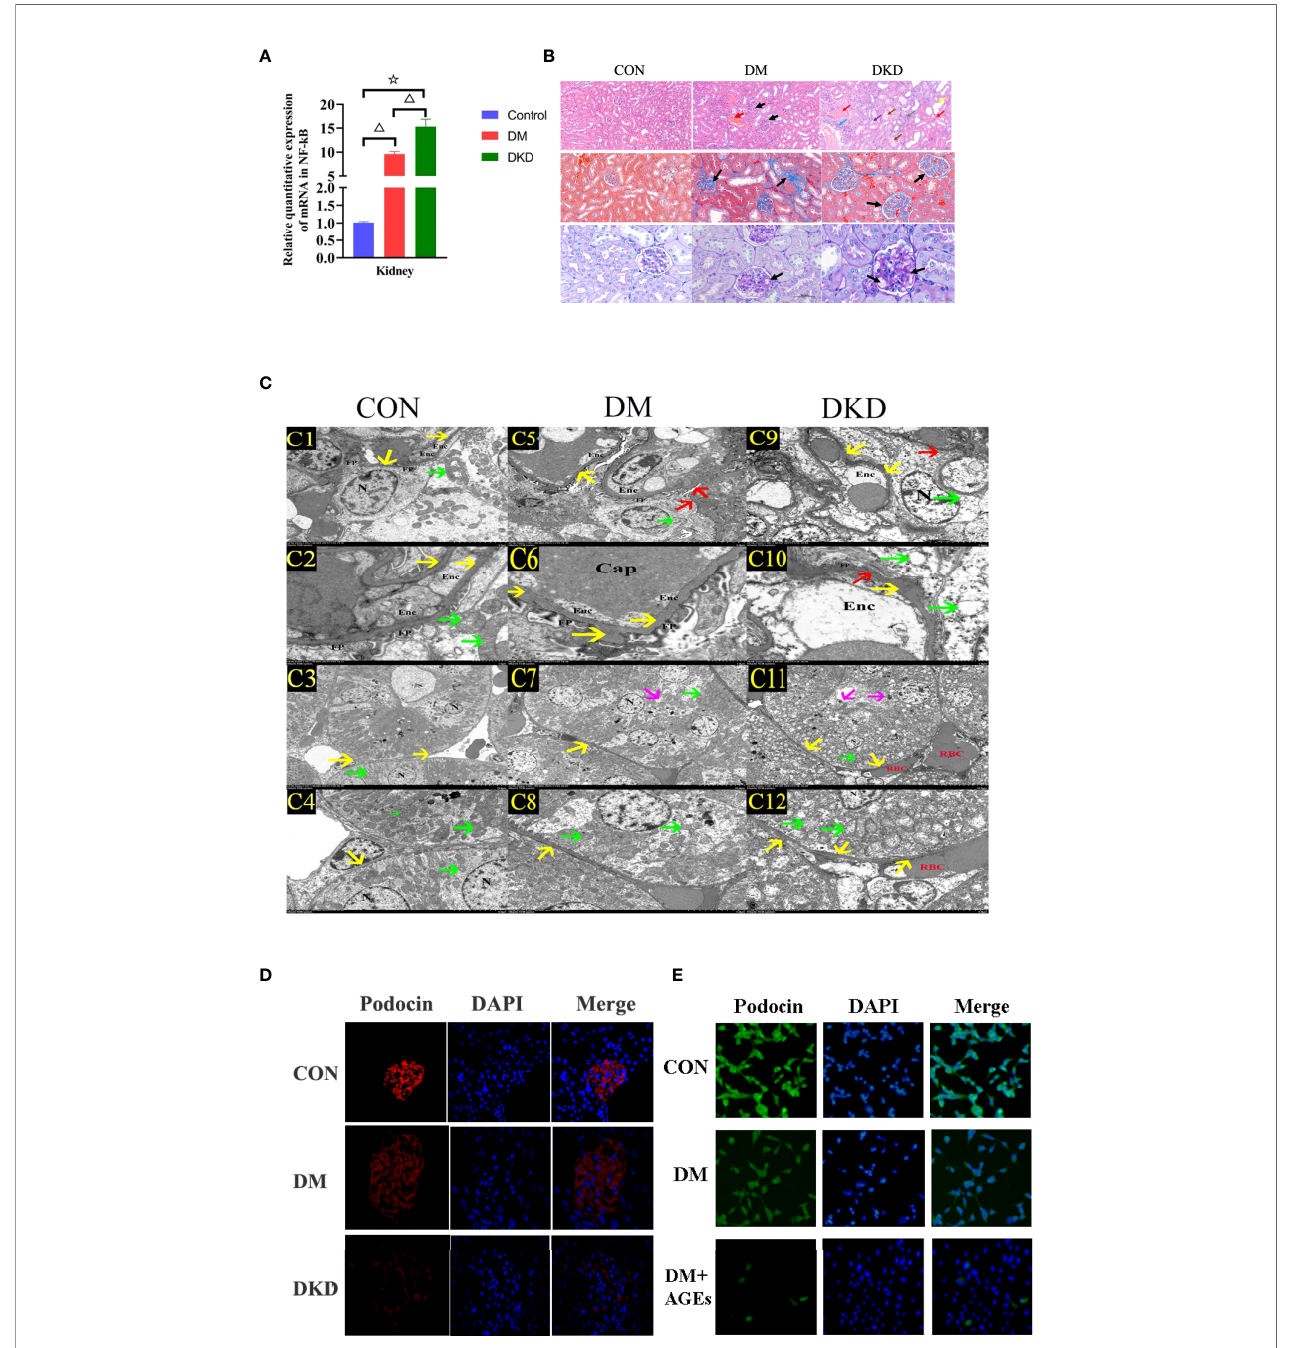
FIGURE 5 | AGEs promote pathological renal damage in DKD mice through the NF- k B signaling pathway. (A) Relative expression of NF- k B mRNA in renal tissues of three groups of mice(n = 6 mice per group). ( △ P<0.01 vs. control; ☆ P<0.01 vs. DM.). (B) Representative pictures of HE, PAS and Masson ’ s trichrome staining in mice from the control group, DM group and DKD group(n = 6 mice per group). (C) Representative pictures of electron microscopy in mice from the DKD group (C1 – C4),DM group (C5-C8) and control group (C9 and C12) (n = 6 mice per group). C1, C5, C9 (2.5 K), C2, C6, C10 (8.0 K), C3, C7, C11 (1.0 K), C4 、 C8 、 C12 (2.5K); C1 、 C2 、 C5 、 C6 、 C9 、 C10: glomerular podocyte;C3 、 C4 、 C7 、 C8 、 C11 、 C12:proximal tubule epithelial cell; Enc: Endothelial cells, RBC red blood cells, FP foot process, N nucleus, yello warrow basement membrane, red arrow the foot process (FP) was fused and widened, green arrow mitochondria, magenta arrow the cell membrane was damaged. (D) Representative images of immuno fl uorescence in mouse podocytes from the control group, DM group and DKD group(n = 6 mice per group) (400x). (E) Representative images of immuno fl uorescence in mouse podocytes from the control group, DM group and DM+AGEs group(n = 6 mice per group)(400x). Podocytes were incubated with 0.2 mg/ml AGEs for 48